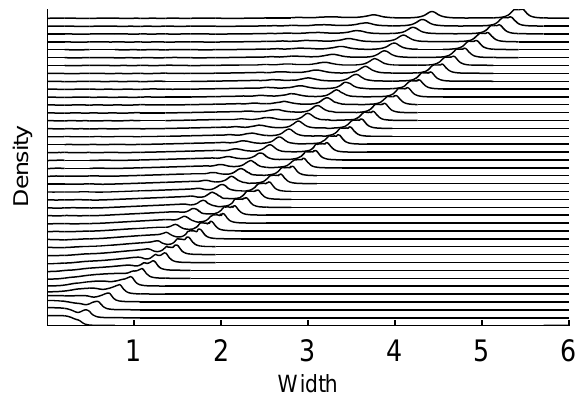
Fig. 5. Waterfall plot of the horizontal wave structure. Notice three clearly defined mode-two waves propagating in time.